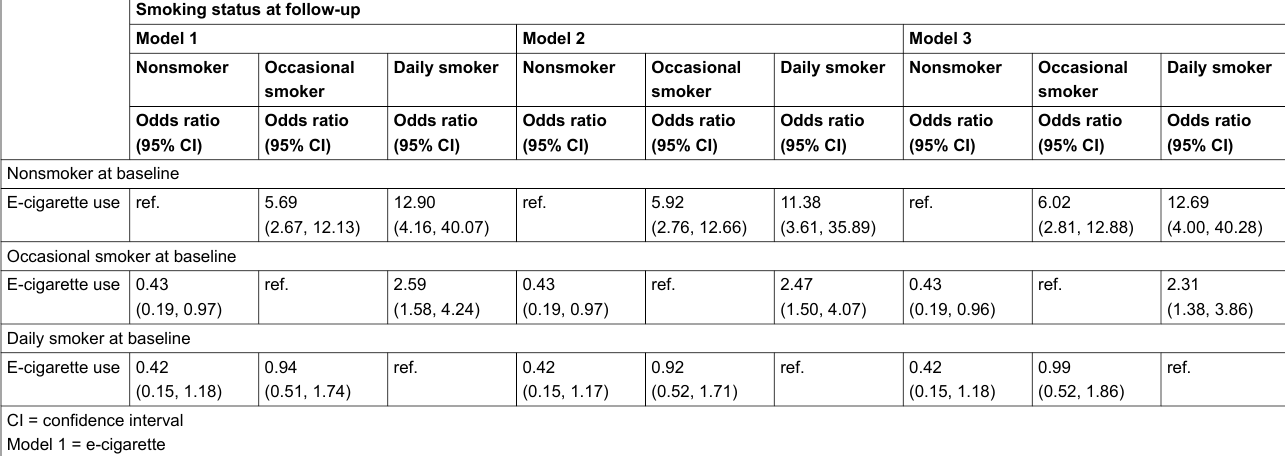
Table 3: Results of multinomial regression models of cigarette smoking status at follow up on e-cigarette use (measured at follow-up only), stratified by cigarette smoking at baseline, Switzerland 2010–2013. Smoking status at follow-up